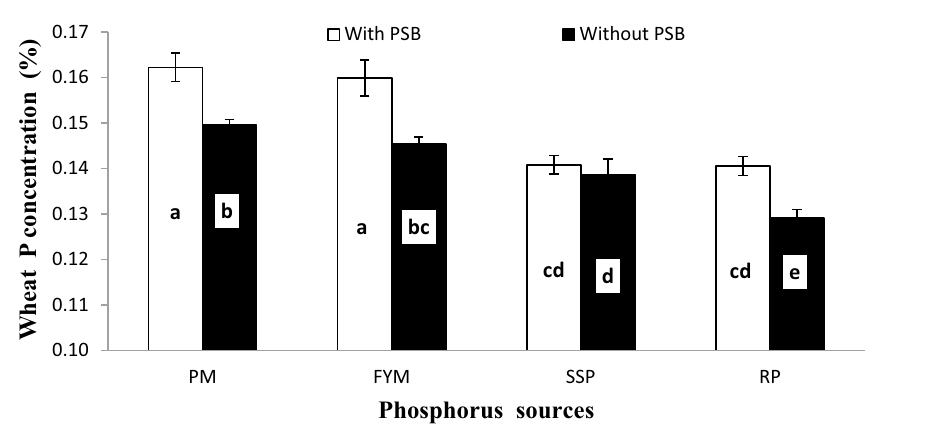
Figure 13. Interactive effect of PSB and P sources on plant P concentration (%).Graph bars having different letters are significantly different at α = 0.05. Errors bar represent standard error for the mean of three values.